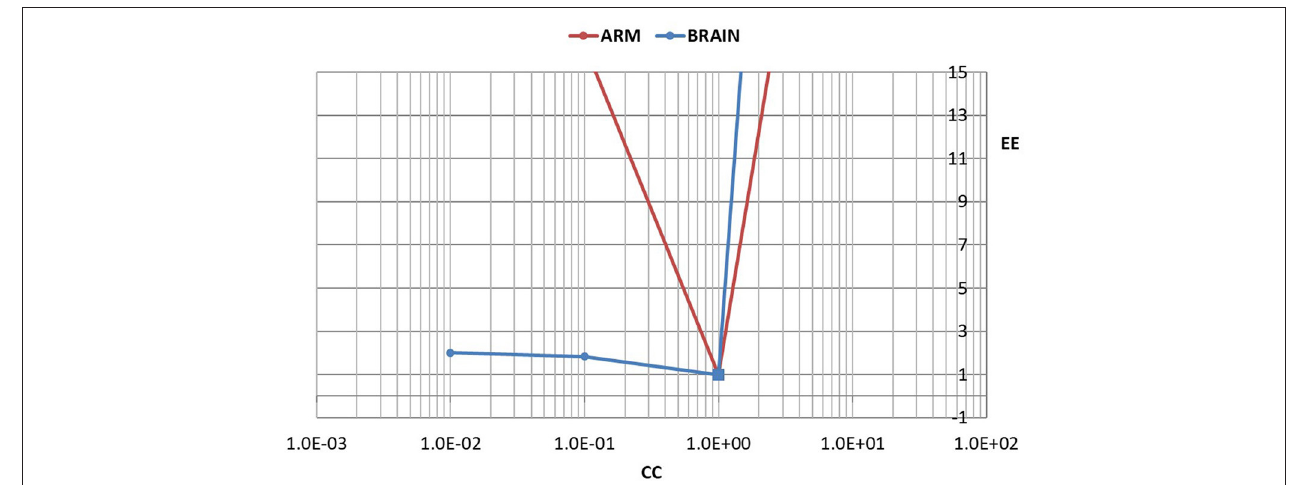
FIGURE 7 | A test of the role of compliance in the relationship between pulsatile pressure and flow, as in Figures 5 , 6 , but here the effect of a change in compliance is quantified in terms of a normalized error “ EE ” between the measured and predicted flow waveform as defined in the text. The error is scaled to 1.0 when there is agreement between the two waveforms (square markers). To facilitate comparison between the results for the cerebrovascular bed with that of the forearm, the changed compliance was scaled in each case by the baseline compliance and a scaled measure of compliance “ CC ” is shown, as defined in the text. In the arm, a change in the value of “ CC ” to either higher or lower values is seen to lead to large errors. In the brain, by contrast, a change to lower values of “ CC ” leads to relatively small error.